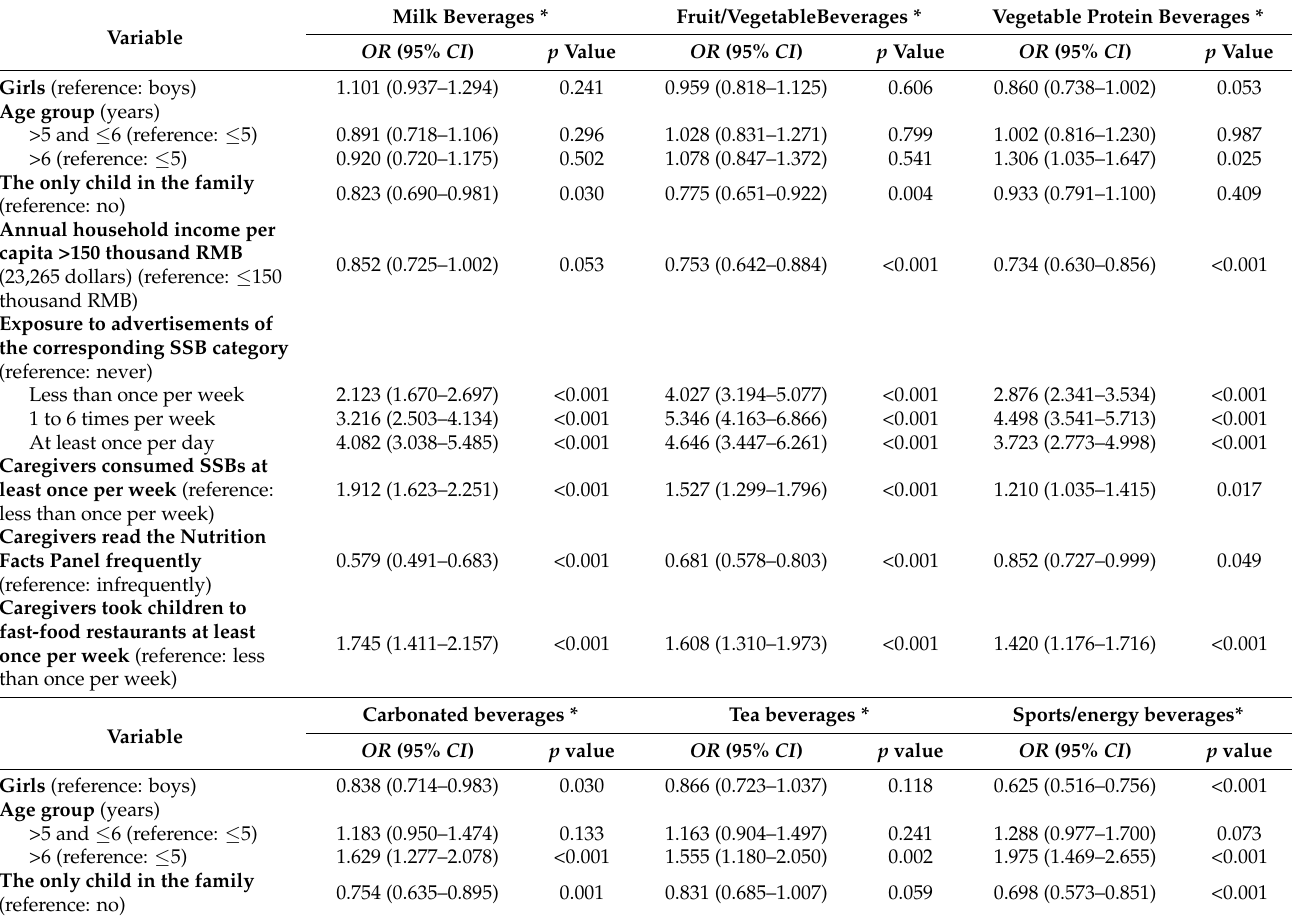
Table 2. Associations between sugar-sweetened beverages (SSBs) consumption over the past three months and exposure to obesogenic environments among preschoolers: multivariate